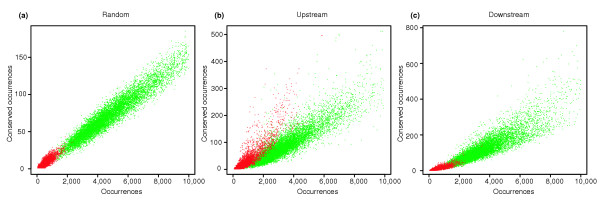
Three panels showing the conservation versus occurrence of all 7-mer words in three different areas of the genome. (a) Random regions. (b) Regions 5 kb upstream of genes. (c) Regions 5 kb downstream of genes. Each word is colored either red if it has one or more CG dinucleotides or green otherwise.